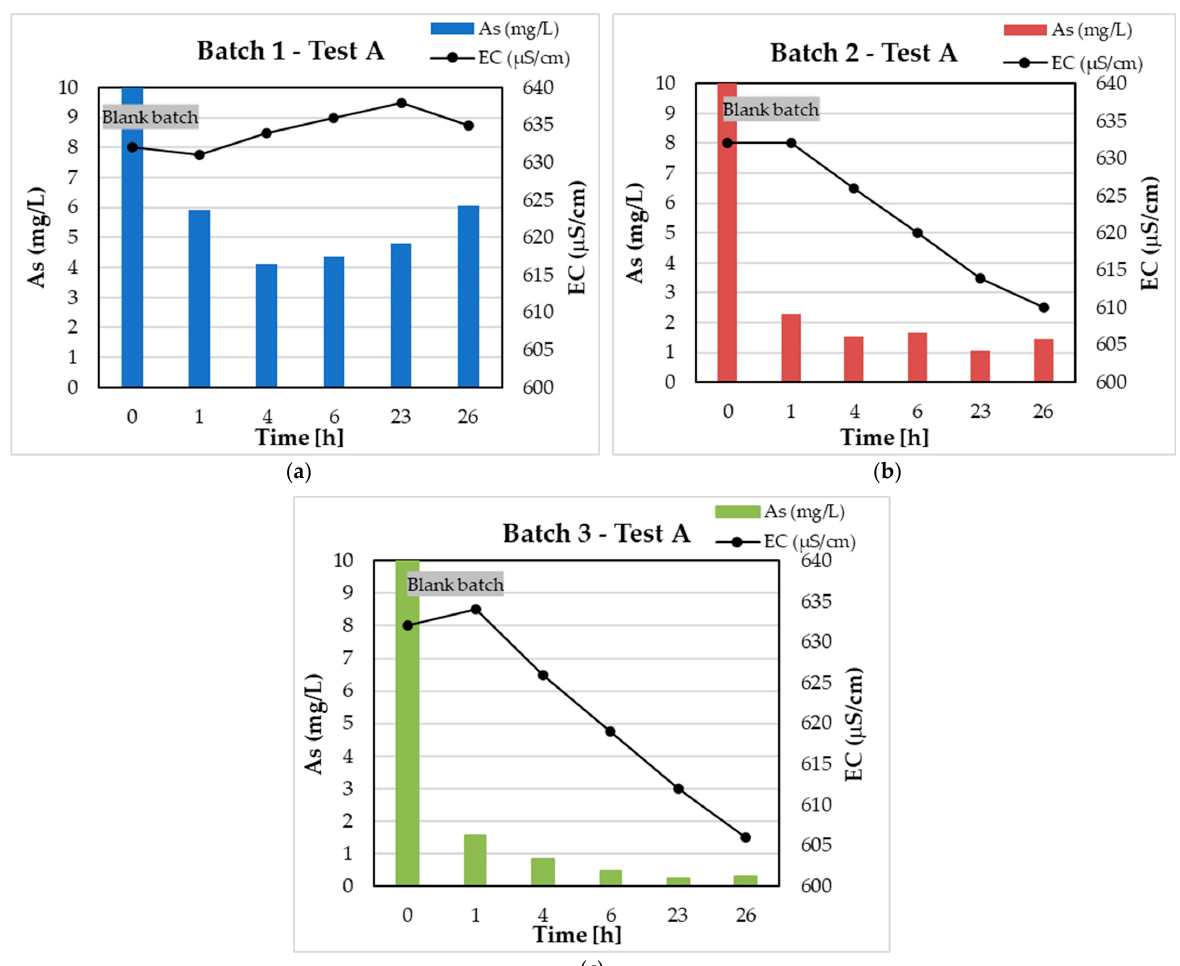
Figure 4. Experimental results for Test A. ( a ) As concentrations trend; ( b ) As removal rate .